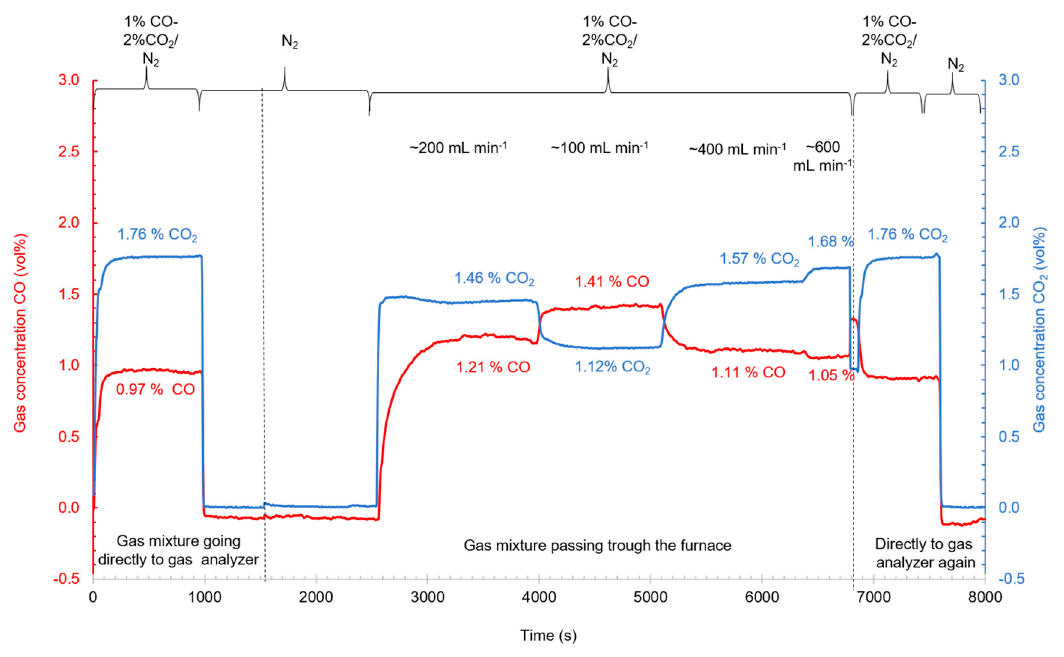
Figure 6. CO-CO 2 gas concentration in Setup Figure 6. CO - CO 2 gas concentration in Setup 2. Figure 6. CO - CO 2 gas concentration in Setup 2.